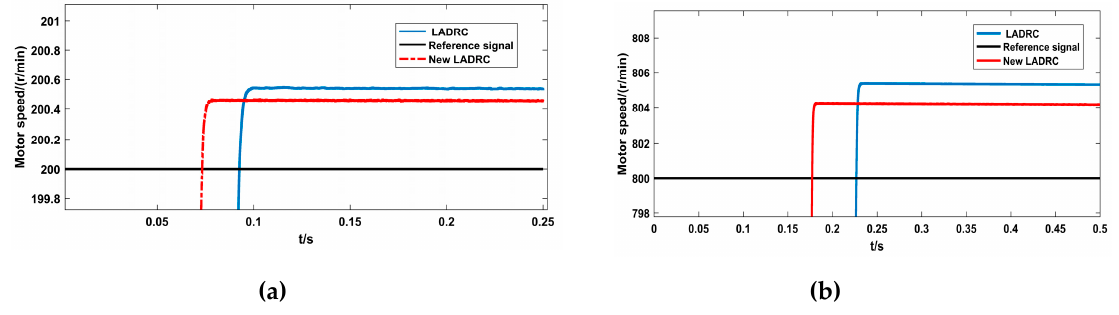
Figure 16. Steady-state error of the system at different speeds.